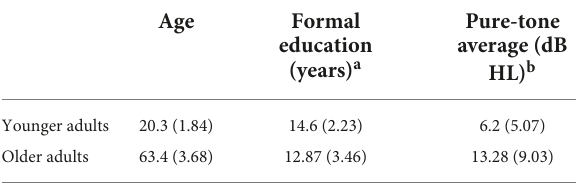
TABLE 1 Participant